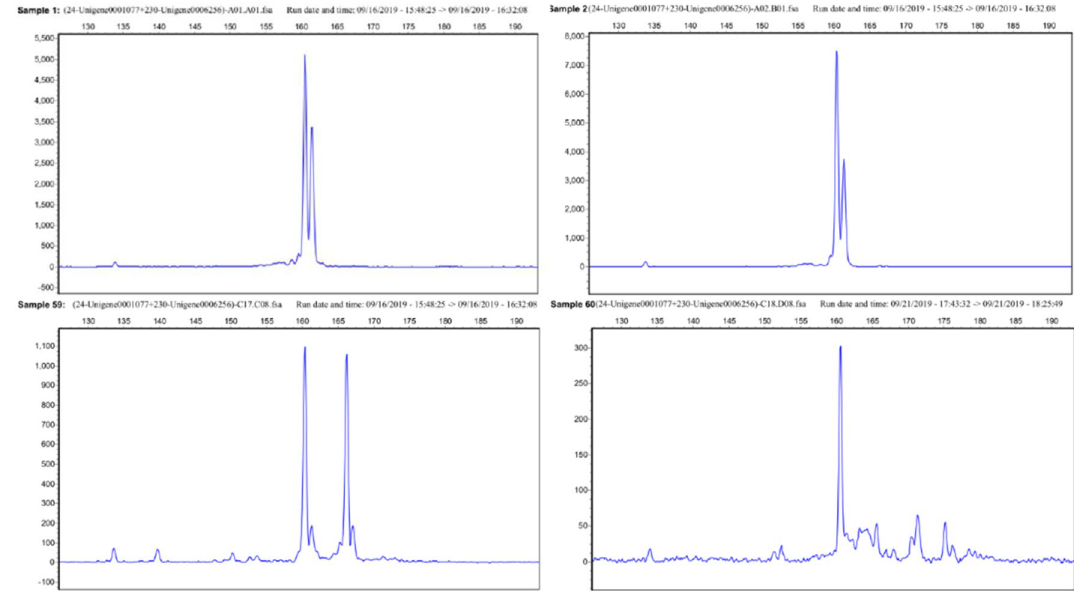
Figure 7. Partial capillary electrophoresis diagram of 60 samples (Genemarker2.2.0; https ://genem arker .softw are.infor